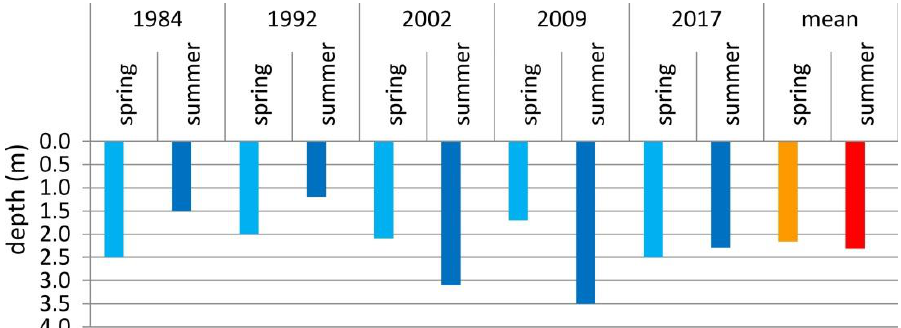
Figure 8. Changes in the Secchi disk visibility (m) in Lake Borówno in 1984–2017 (prepared based on unpublished VIEP data).